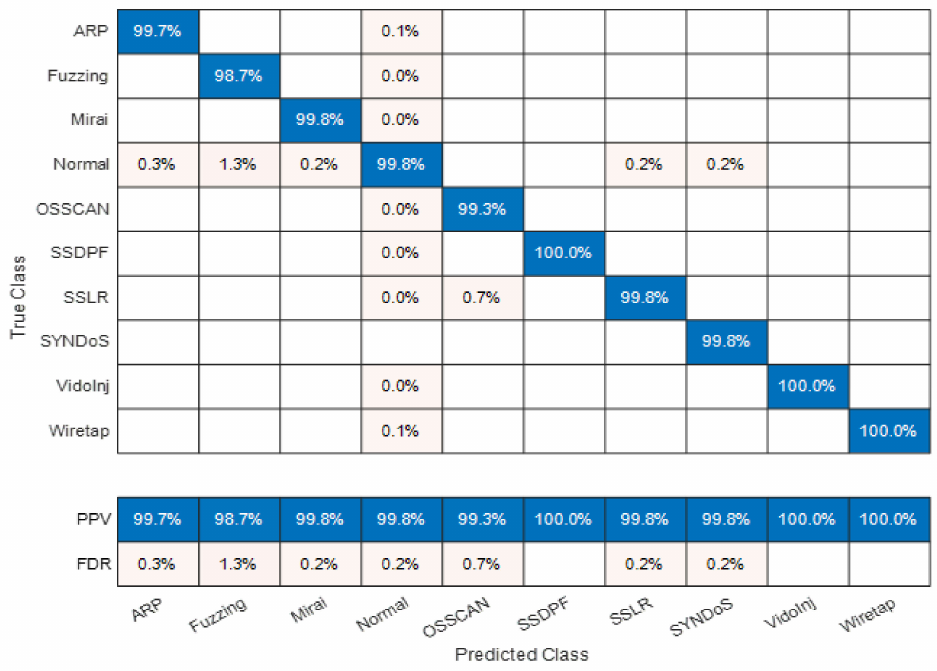
Figure 6. Matrix of PPV vs. FDR for each individual class using EBT classifier.